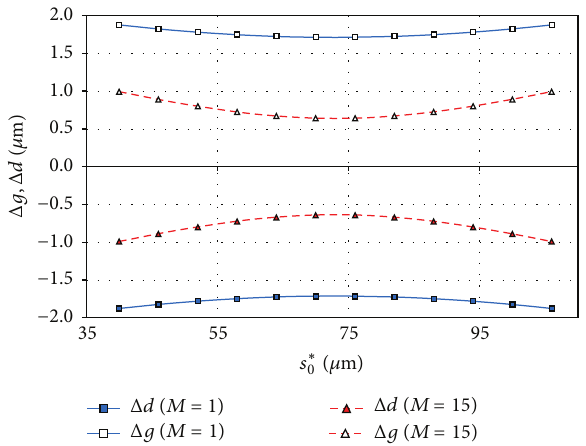
Figure 5: Calibration uncertainties for air gauges with measuring nozzle 𝑑 𝑝 = 1.810 mm and outer inlet nozzle 𝑑 𝑤 = 0.720 mm